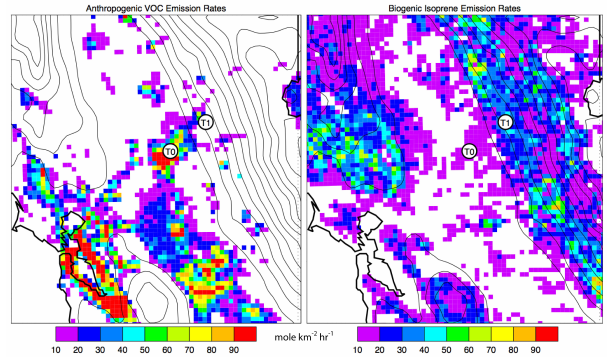
Fig. 2. Emission rates in the Central Valley at 11:00 PDT. Left panel: sum of all anthropogenic VOCs. Right panel: biogenic iso-